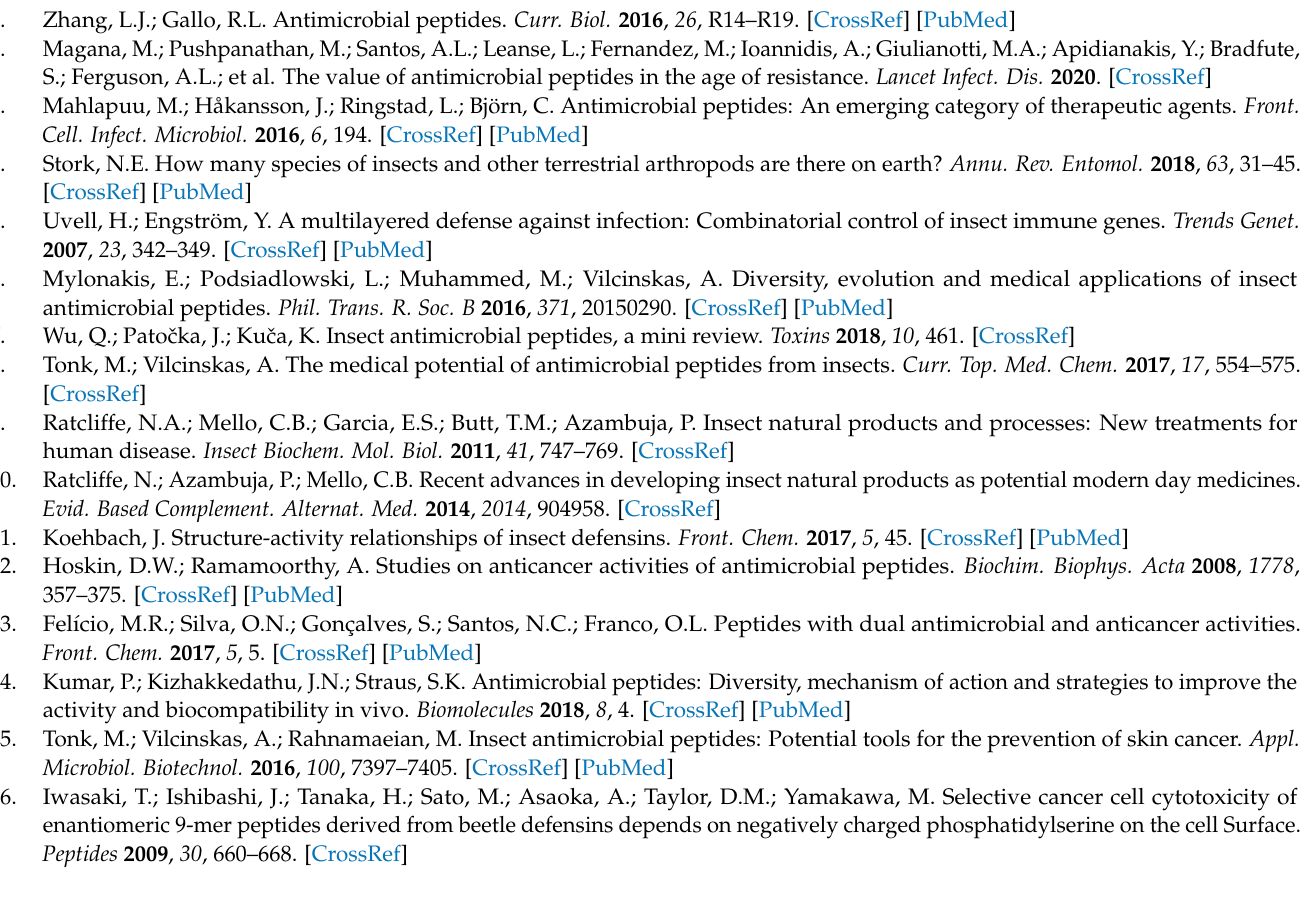
four top hits in the PDB data banktitle. Figure S2: Helical wheel projection of the predicted α -helix region of TcPaSK peptide. Table S1: Minimum inhibitory concentration (MIC) of TcPaSK against S. aureus . Table S2: Hemolytic activity of TcPaSK peptide against human red blood cells at different